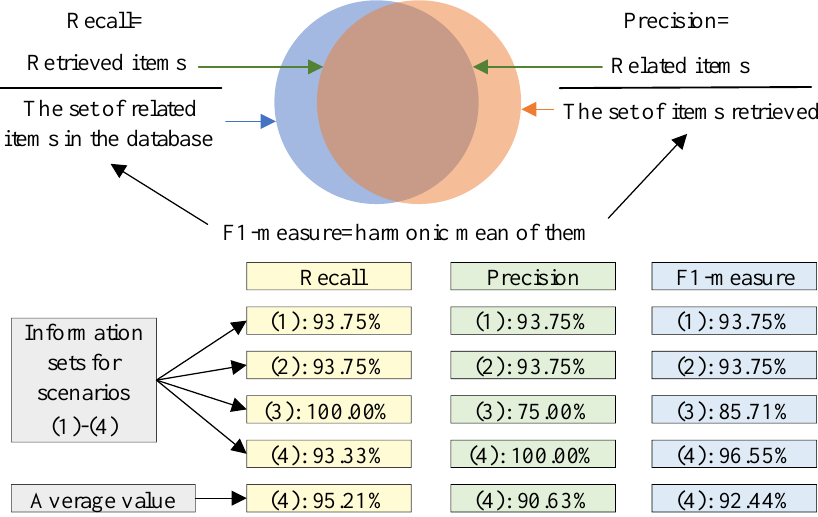
Figure 18. The specific interpretation recall, precision, and the F1-measure and the test results.